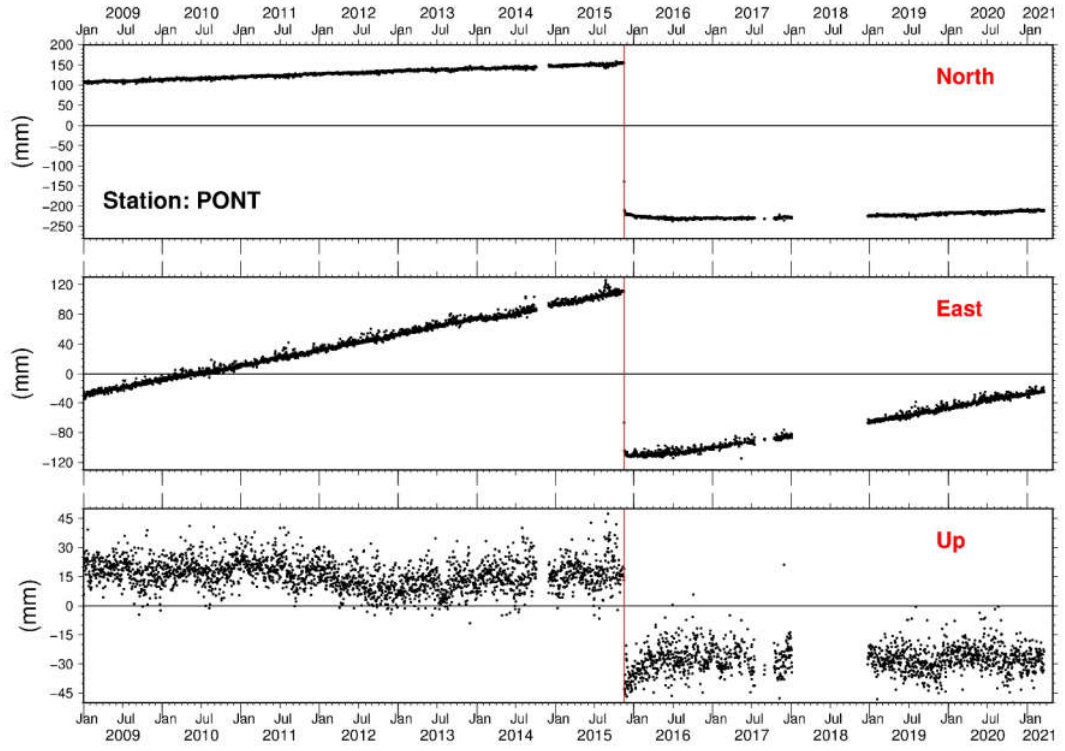
Figure 4. Time series of PONT continuous GNSS stations located in Lefkas island. Red line indicates the date of the 2015 seismic event.